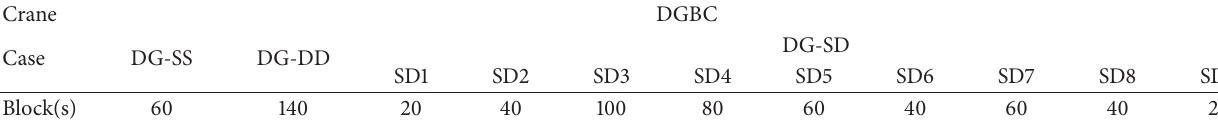
Table 4: Blocking time of DG-SS, DG-DD, and DG-SD.